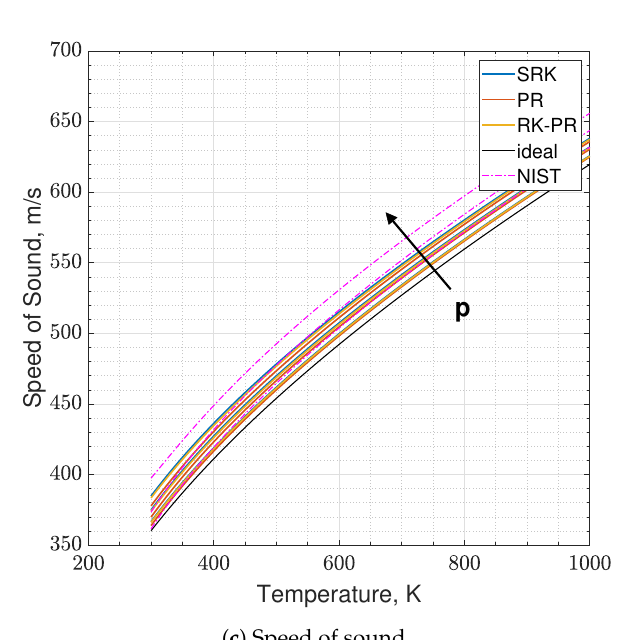
Figure 4. Comparison of the present EoS in its SRK, PR and RK-PR modes with refprop data and ideal behavior. Mixture is O 2 - CH 4 with O/F = 3.4. Temperature range is 300–1000 K. Pressure values are 6, 12 and 18